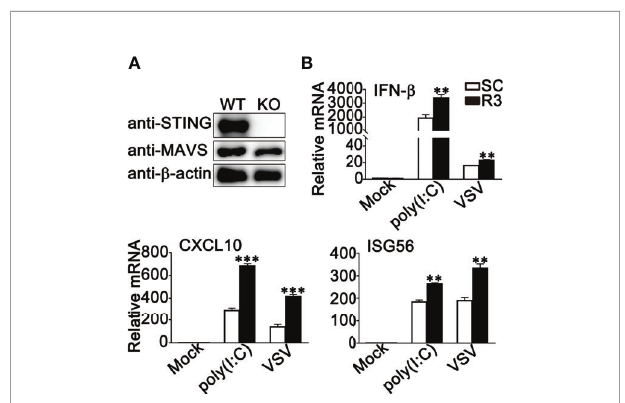
FIGURE 7 | RNF90 inhibits RNA virus-triggered innate immune responses independent of STING Signaling. (A) WT and STING-de fi cient (KO) PMA-THP1 cells were lysed for immunoblot analysis. b -actin served as a loading control. (B) STING-de fi cient (KO) PMA-THP1 cells were transfected with control siRNA (SC) or RNF90-speci fi c siRNA (R3) for 24 h and then transfected with poly (I:C) or infected with VSV for 8 h. Then, the cells were lysed for real-time PCR assays. The data are representative of three independent experiments and are presented as mean ± SEM. ** P < 0.01, *** P <